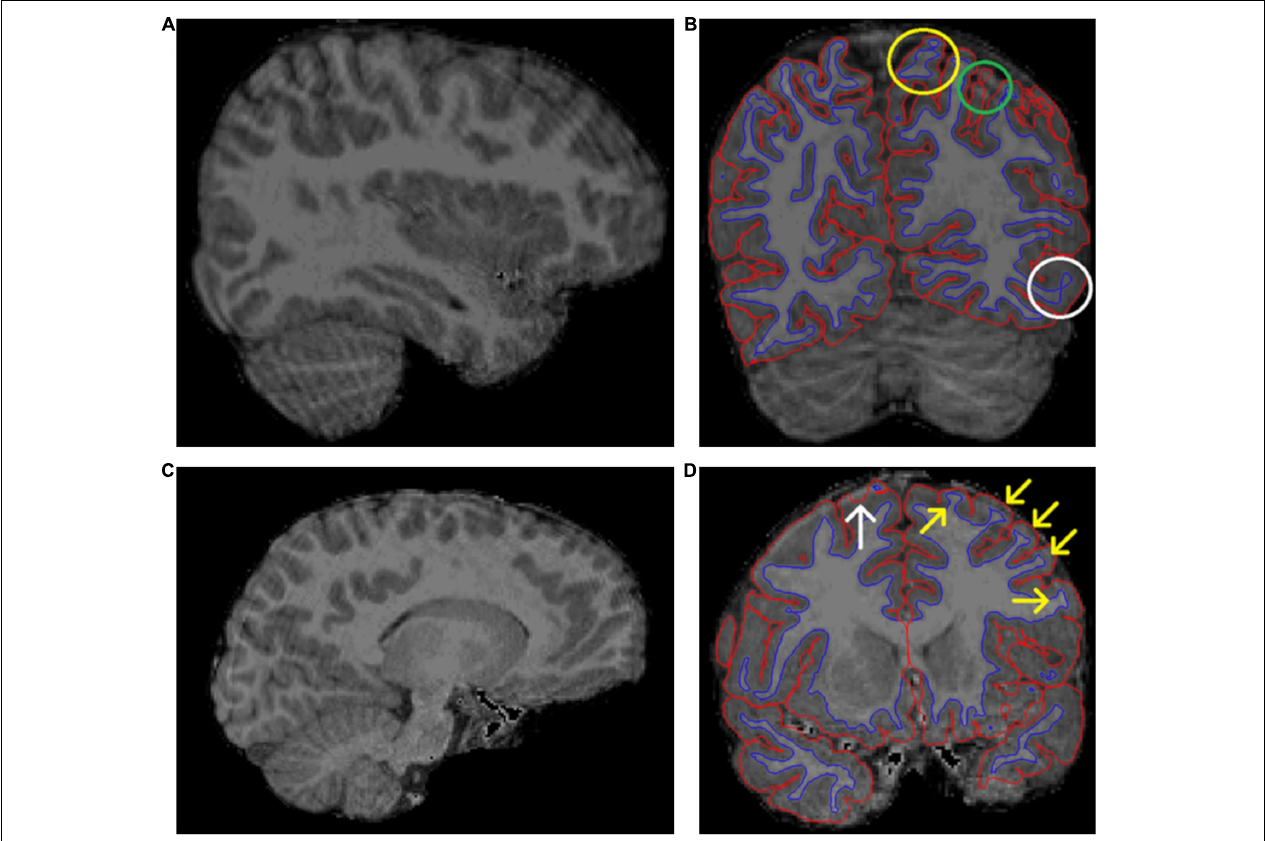
FIGURE 4 | Two examples of excluded brain images. (A) Shows “waves” throughout the image, marking motion artifact. (B) Shows the same subject as in panel (A) in a coronal view and borders visible. This image shows motion artifact related errors in the border between white and gray matter (WM–GM border), denoted by the yellow circle. Additionally, there is potential unsegmented area due to motion artifact (green circle) and poor contrast between WM and GM (white circle). (C,D) Show another excluded subject. The motion artifact in panel (C) is not as pronounced as in panel (A) . However, (D) still shows some typical errors for images with much artifact. There is a clear pial error (white arrow). Additionally, the yellow arrows show typical cases, where the “ringing” causes the WM mask to “widen” where the actual WM meets the ringing motion artifact. Similarly, in cases with supramarginal gyrus overestimation